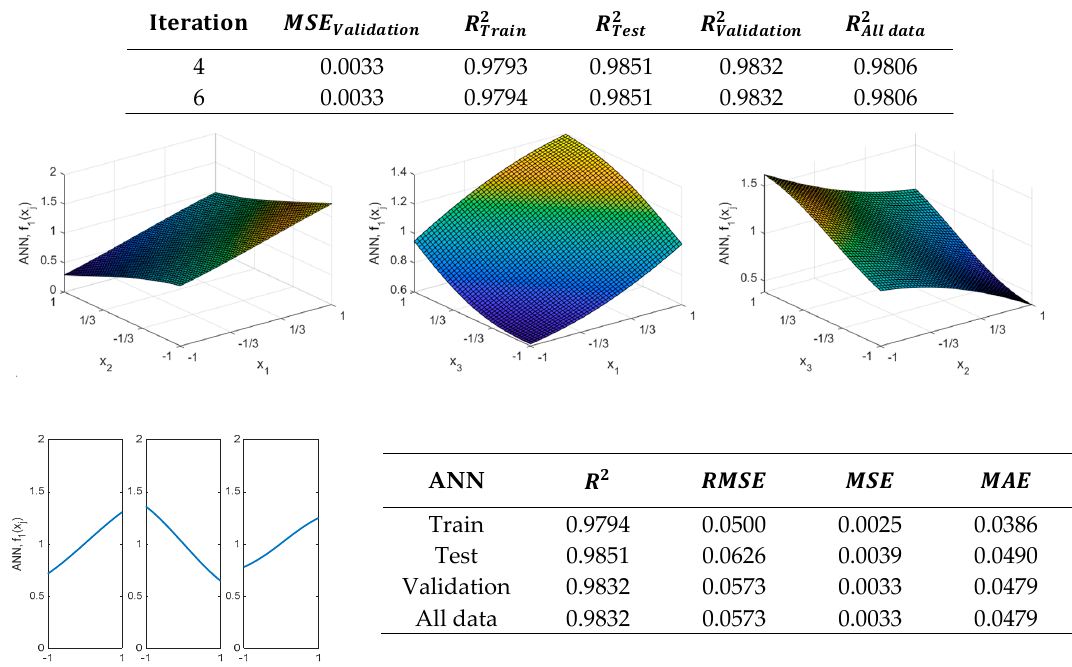
Figure 9. Response surfaces obtained, main effects plot and results of the validation metrics obtained with the ANN model for the case of type 1 function ( f 1 ) ( n = 2 neurons ) .